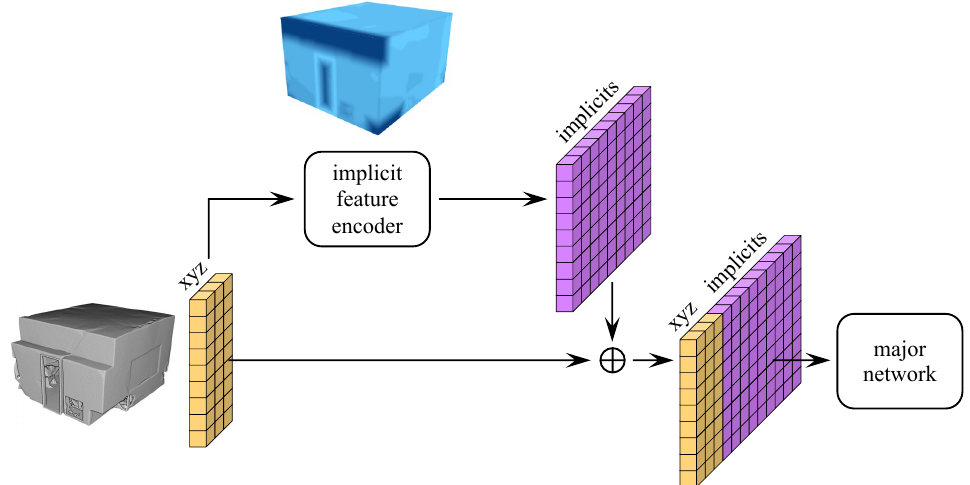
Figure 1. The proposed implicit feature encoding. Given a point cloud as input, its unsigned distance field (UDF) is sampled as pointwise canonical feature vectors and concatenated after the point coordinates, forming a more expressive point cloud representation. The UDF is color-coded from bright to dark in ascending order of the distance values of the